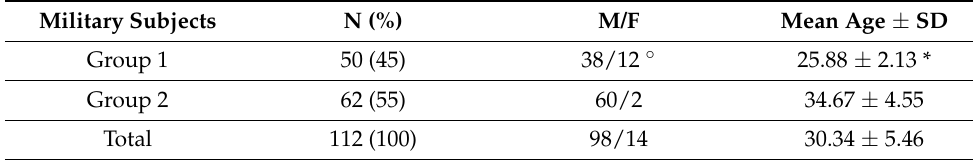
Table 1. Demographic data of the military of group 1 and group